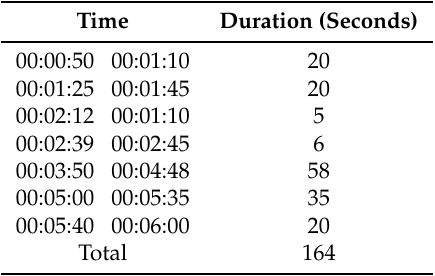
Table 3. Testbed: tested video ground-truth motion